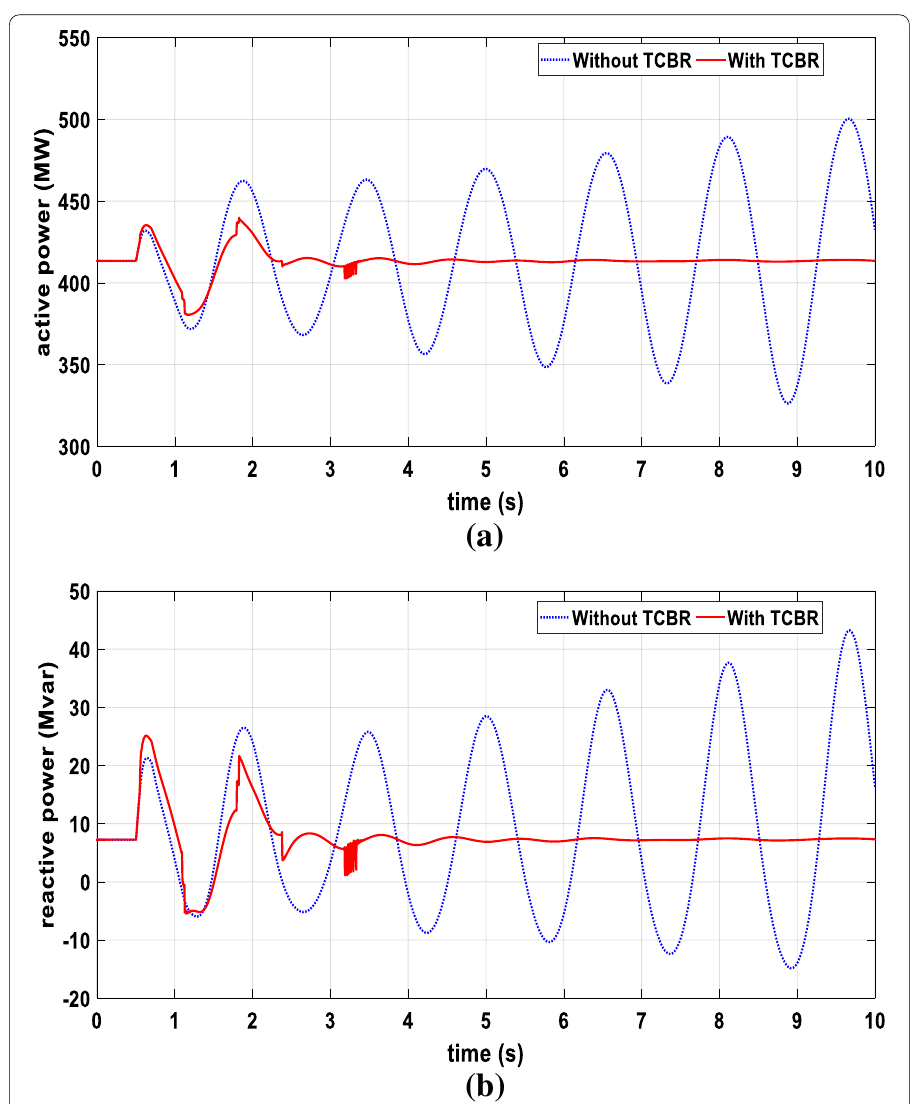
Fig. 5 Power flow responses to the small disturbance with and without the TCBRs interventions, a inter‑area active power flow, b inter‑area reactive power